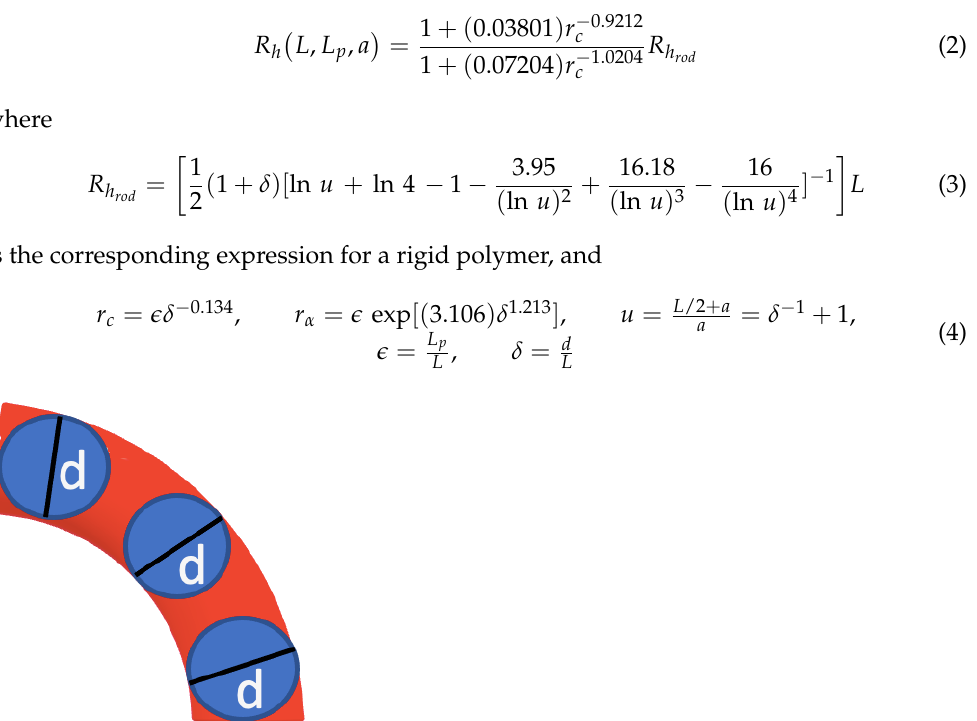
Figure 1. Cylindrical model of the wormlike chain enclosing a number of beads representing the actin filaments where the persistence length is a predominant factor in the theory of diffusion coefficient as well as the electrophoretic